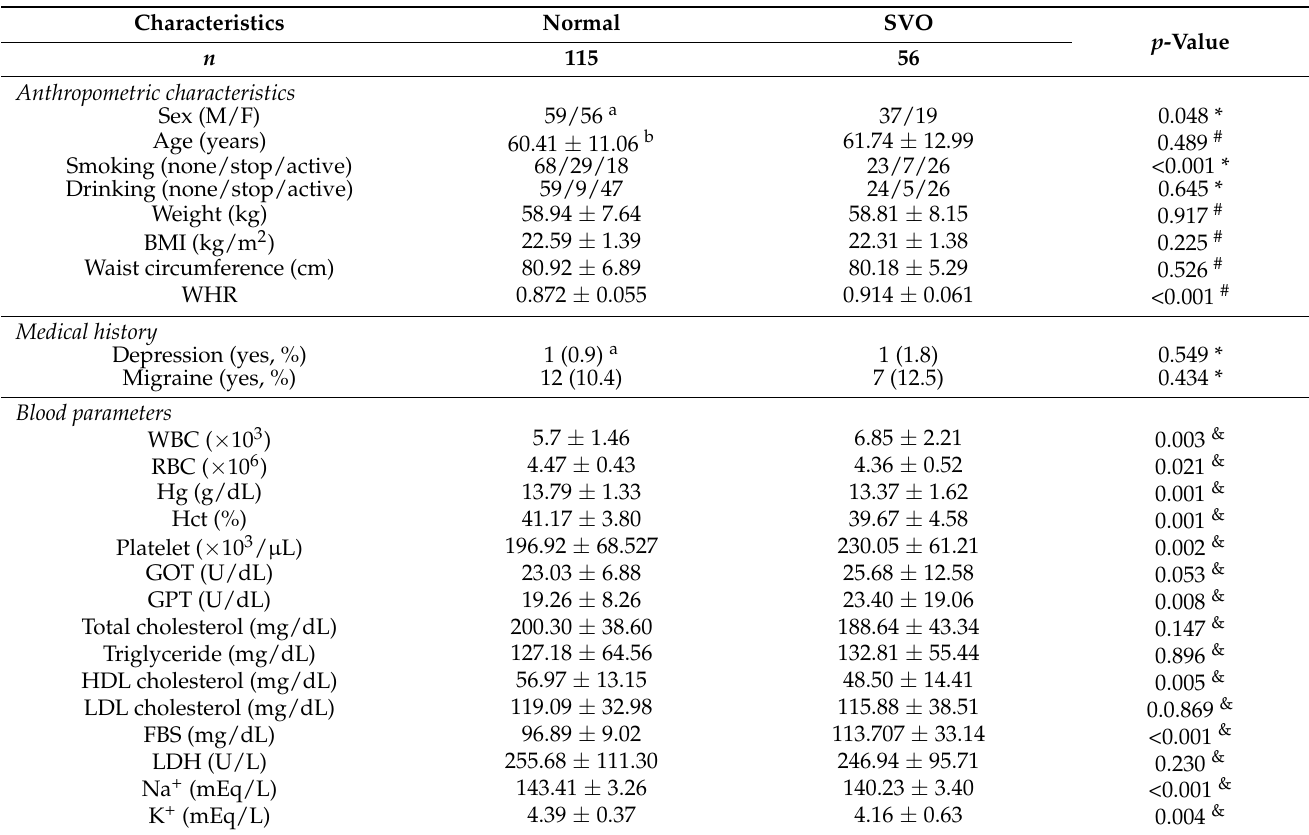
Table 1. General characteristics of normal subjects and of patients with small vessel occlusion (SVO). Characteristics